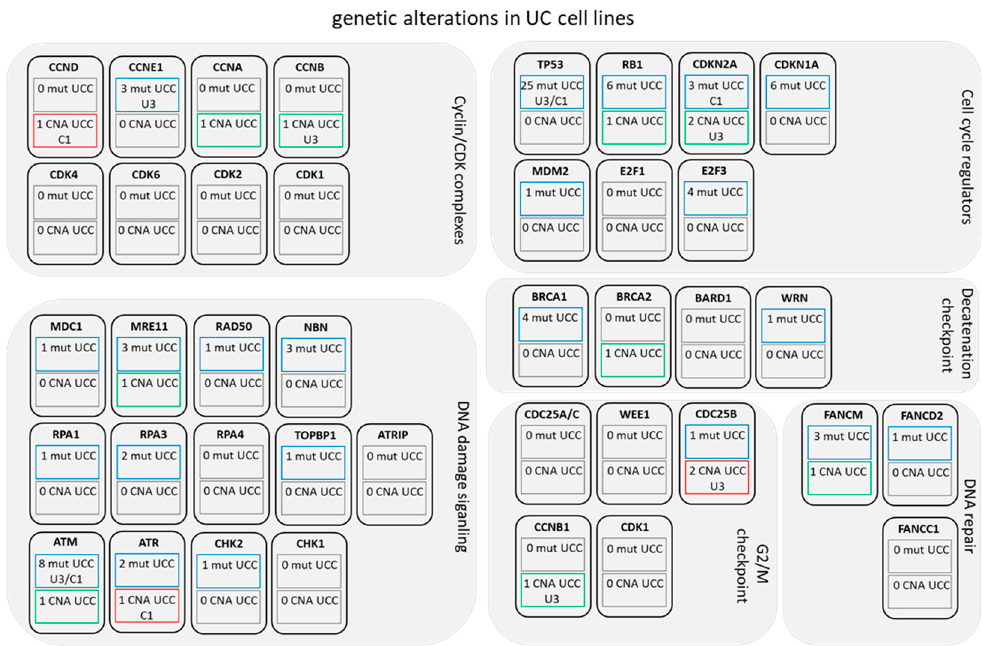
Figure 2. Alterations in cell cycle and checkpoint control genes in UC cell lines by genetic changes. CCLE data was queried via the Broad Institute database for 31 urinary tract cancer cell lines for genetic mutations. Queried genes are displayed as boxes arranged according to their regulatory function in cell cycle control and DNA damage response. Upper inserted blue lined boxes mark genes with known mutations in the number of UC cell lines. If the two UC cell lines VM-CUB1 and UM-UC-3 were among the mutated lines, they are listed specifically below as “C1” and “U3”. Grey lined boxes indicate no mutation in the 31 cell lines. The second box below likewise informs about copy number alterations (CNA). Green lined boxes indicate deletions, red lined boxes indicate amplifications.